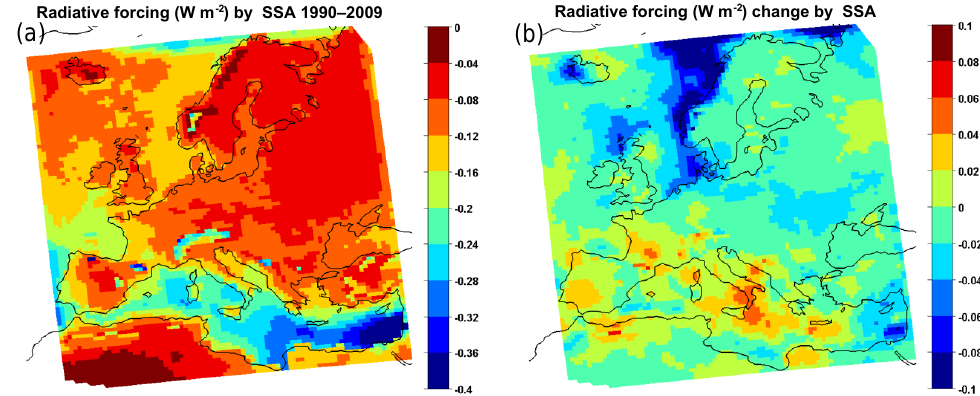
Figure 10. Radiative forcing by sea salt (Wm − 2 ). (a) Past period (1990–2009); (b) absolute difference between future (2040–2059) and past periods.